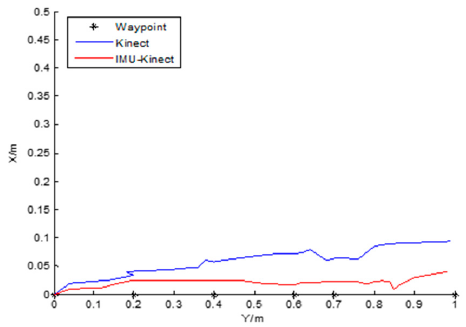
Figure 10. Straight track.